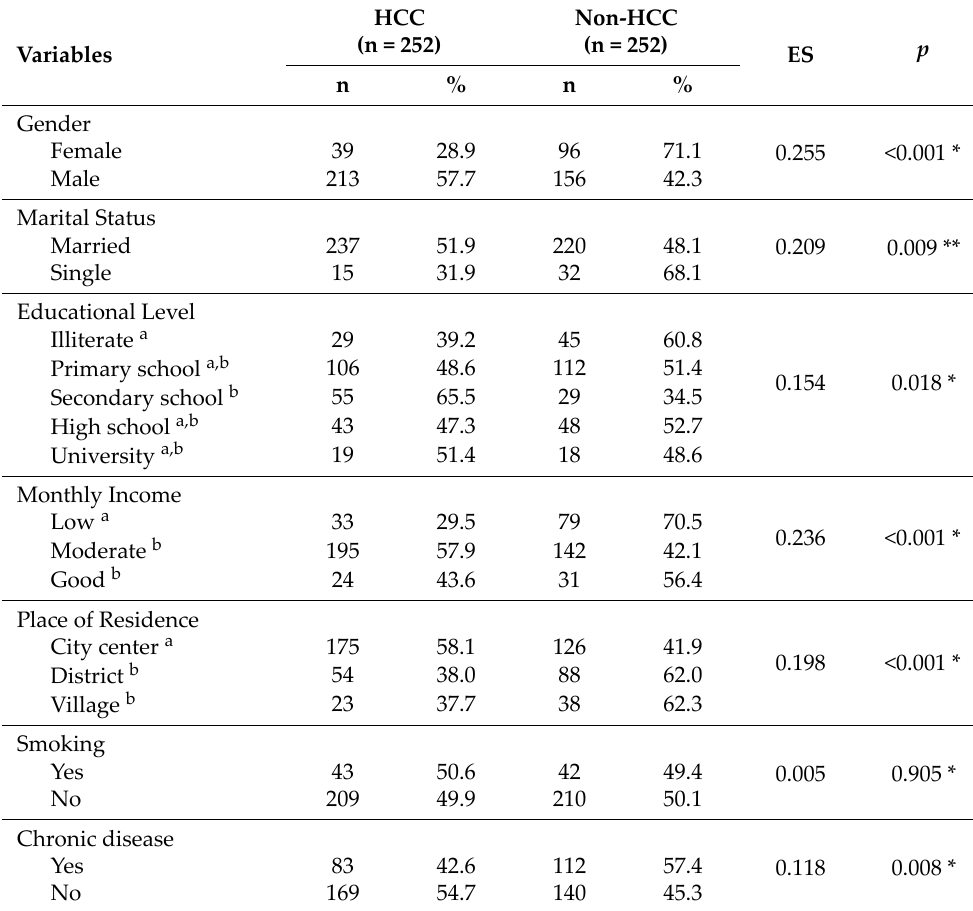
Table 1. Comparison of the groups in terms of sociodemographic features.